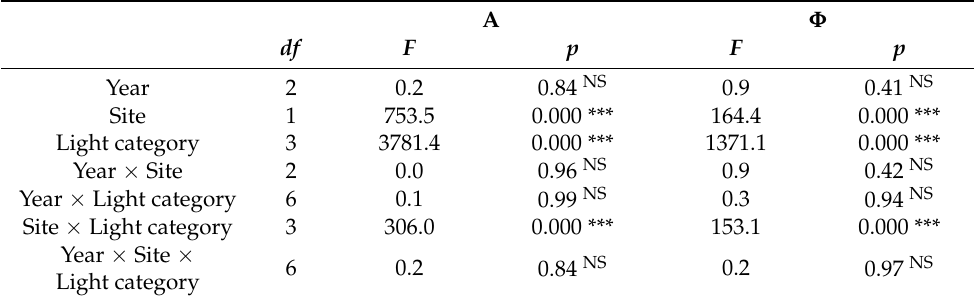
Table 4. Differences in A and Φ between years, sites and light categories. Probability values of p < 0.001 (***) were considered significant;